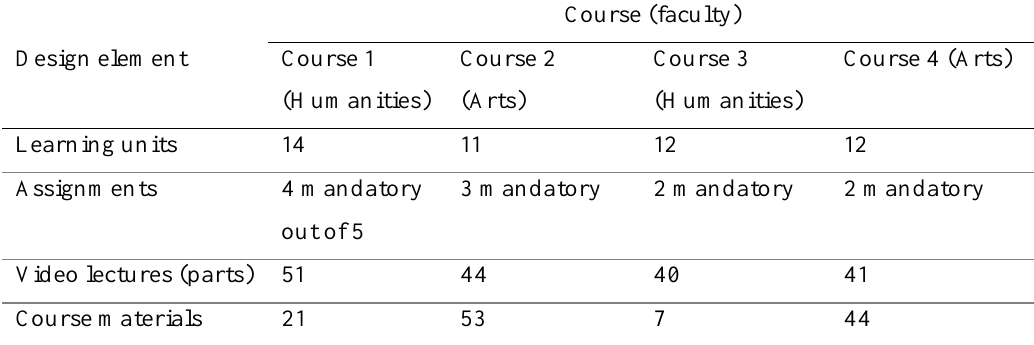
The Structure of the Online